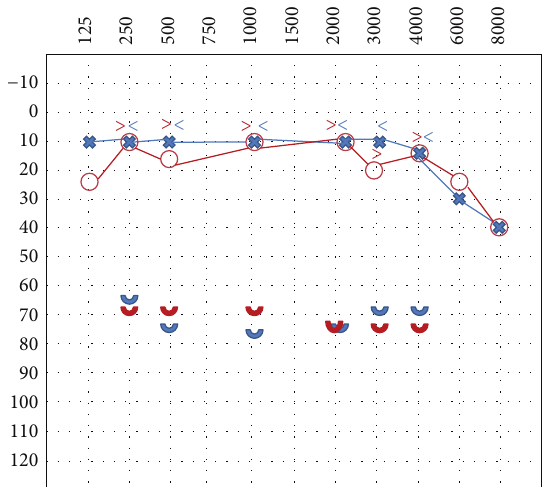
Figure 4: Audiological test with ULL showing moderate hyperacu- sis after the